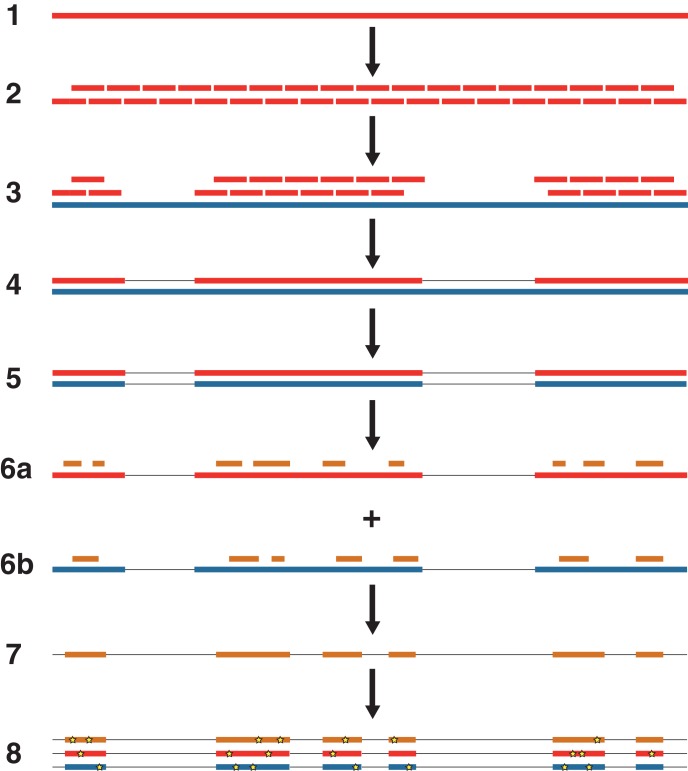
An overview of the nuclear genome analysis pipeline.A first reference genome sequence (red; step 1) is divided into 150 bp pseudo-reads, tiled every 75 bp for exactly 2 × genomic coverage (step 2). These pseudo-reads are then mapped to a second reference genome (blue; step 3), and a consensus sequence of the mapped pseudo-reads is called (step 4). Regions of the second reference genome that are not covered by the pseudo-reads are masked (step 5). For each NWSL equid sample, reads (orange) are mapped independently to the first reference consensus sequence (step 6a) and masked second reference genome (step 6b). Alignments from steps 6a and 6b are then merged (step 7). For alignment coordinates that have base calls for the first reference, second reference, and NWSL equid sample genomes, the relative frequencies of private transversion substitutions (yellow stars) for each genome are calculated (step 8). The co-ordinates from the second reference genome (blue) are used for each analysis.